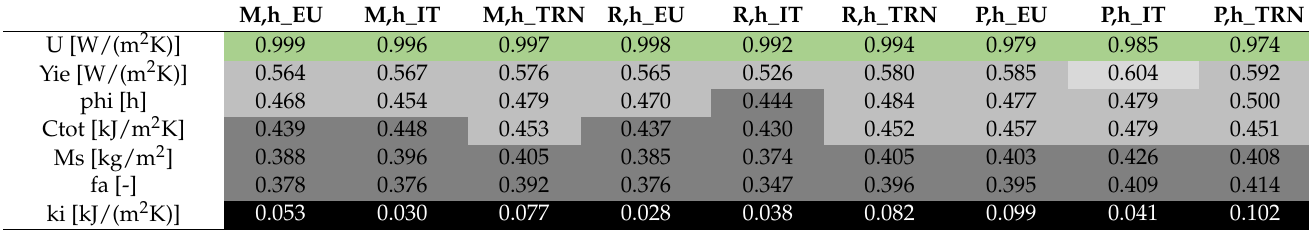
Table A2. Weight analysis of the thermo-physical attributes of opaque structures, for the winter period and with g gl = 0.77.